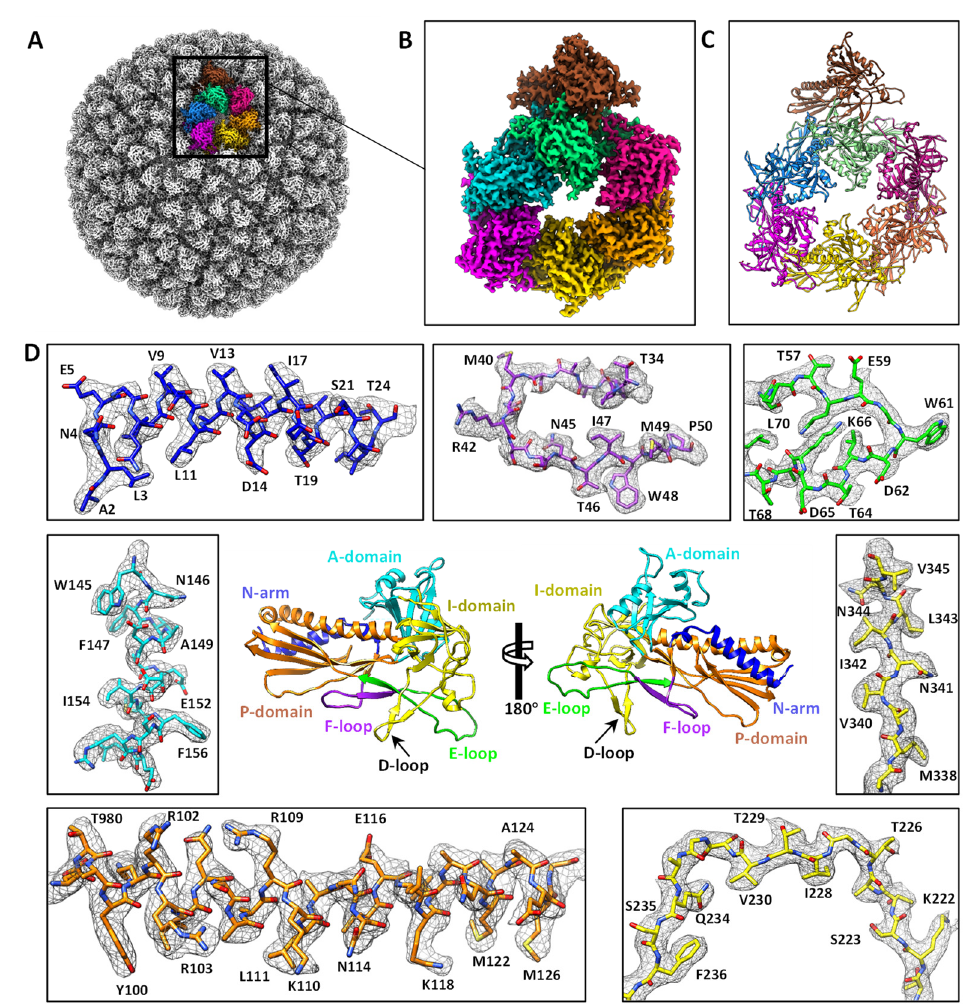
Figure 1. The cryo ‐ EM structure of the P22 procapsid. (A) The overall structure of the procapsid. 174 Figure 1. The cryo-EM structure of the P22 procapsid. ( A ) The overall structure of the procapsid. The seven subunits of the procapsid asymmetric unit are in different colors. (B) The segmented 175 The seven subunits of the procapsid asymmetric unit are in different colors. ( B ) The segmented asymmetric unit from the local reconstruction of procapsid. (C) Accurate atomic models based on 176 asymmetric unit from the local reconstruction of procapsid. ( C ) Accurate atomic models based on the density map in panel B. (D) Density maps of gp5 at 2.6 Å resolution superimposed on their 177 the density map in panel B. ( D ) Density maps of gp5 at 2.6 Å resolution superimposed on their atomic models. The gp5 structure is divided into six domains, namely, N ‐ arm, P ‐ domain, I ‐ domain, 178 atomic models. The gp5 structure is divided into six domains, namely, N-arm, P-domain, I-domain, A ‐ domain, F ‐ loop, and E ‐ loop. 179 A-domain, F-loop, and